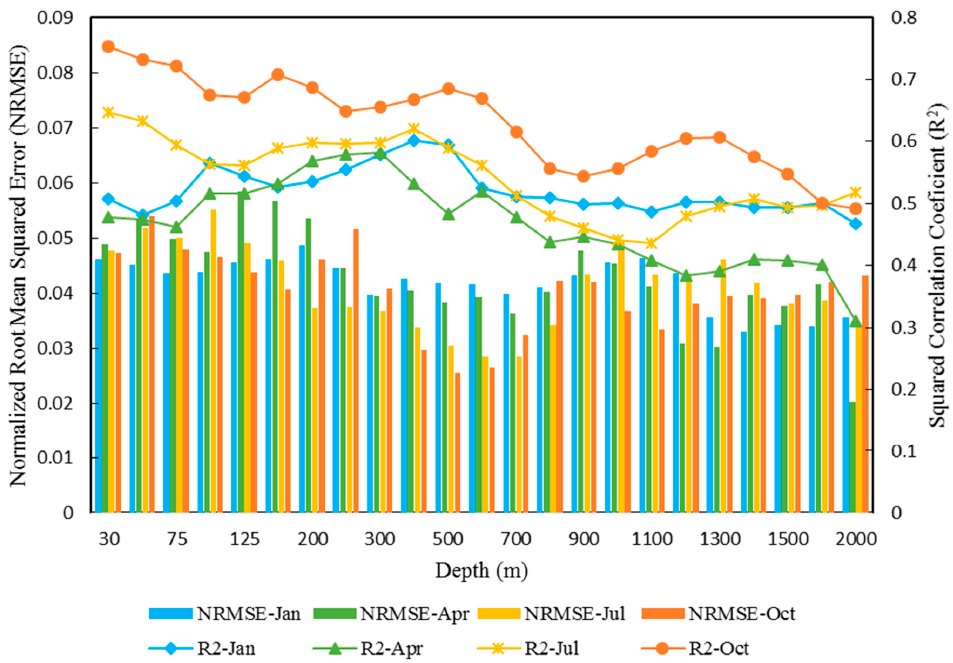
Figure 7. Accuracy evaluation of STA estimation results of the 23 different depths and the different seasons in the global ocean based on the XGBoost model. Blue indicates January (winter), green indicates April (spring), yellow indicates July (summer), orange indicates October (autumn), the lines display R 2 , and the histograms display the NRMSE.